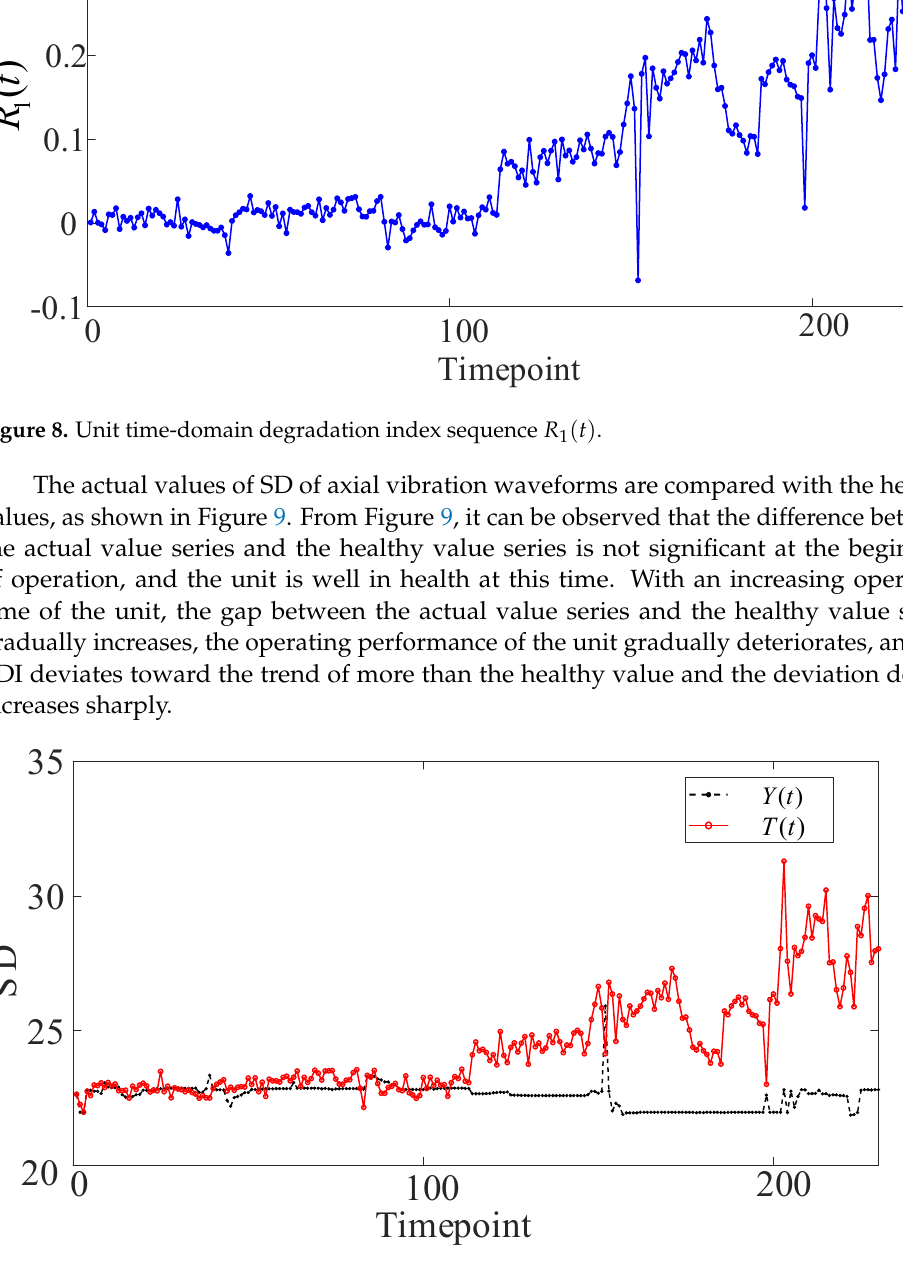
Figure 9. Comparison between T ( t ) and Y ( t ) .